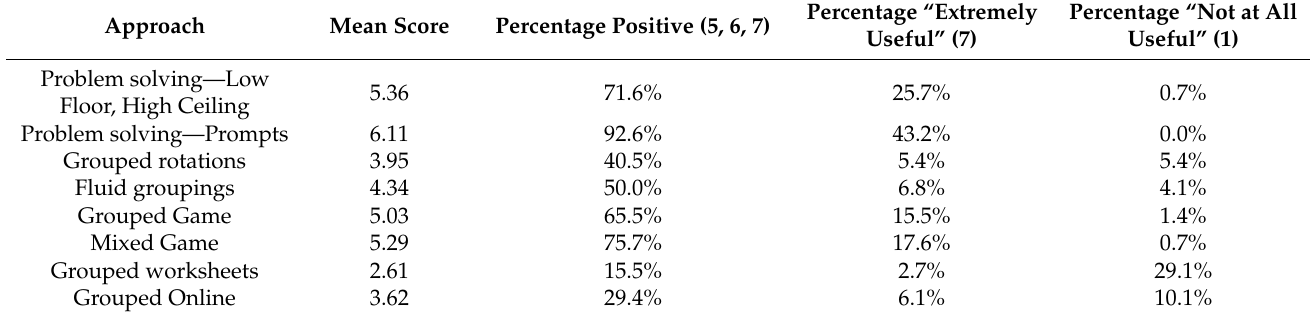
Table 3. Pre-intervention ( n = 148) teacher responses.